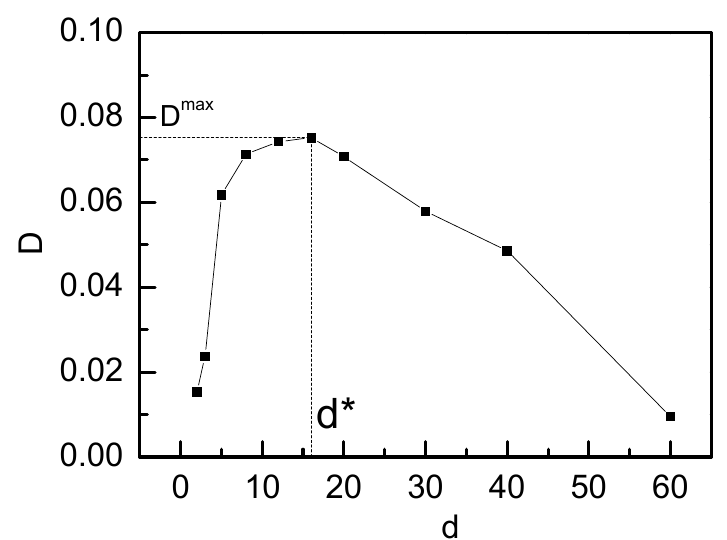
Figure 5. Diffusion coefficient Dof ring chain on the symmetric fluctuating axial chains (K 1 = K 2 = 0) with different distances d between two symmetric fluctuating axial chains.